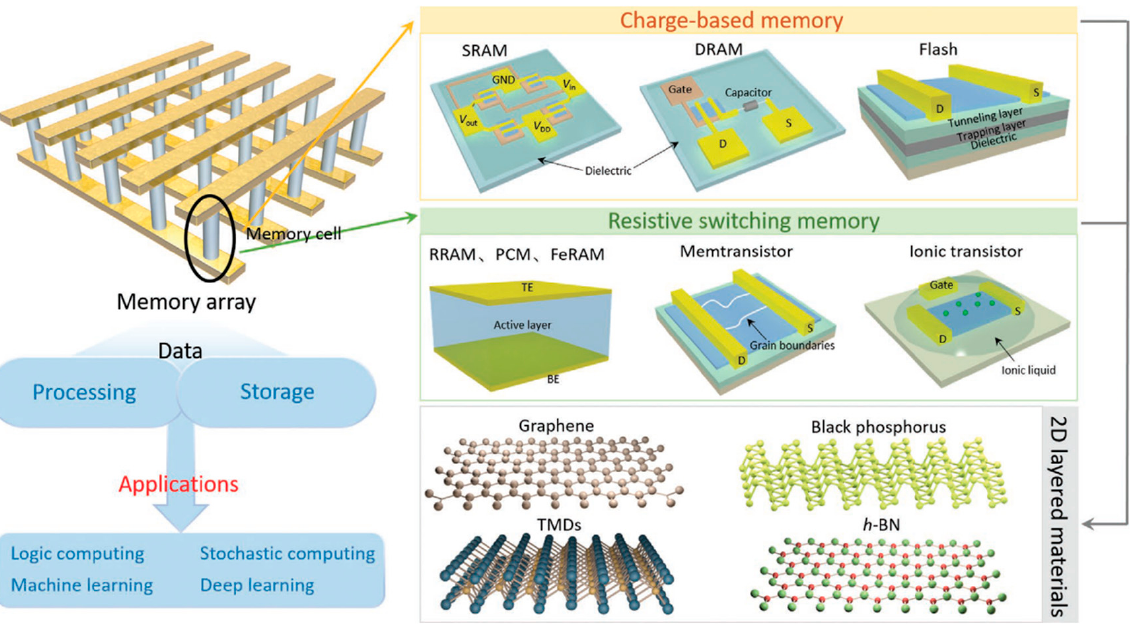
Figure 9. Memory devices based on 2D materials for in-memory computing. In the case of in-memory computing, logic operations are executed in situ within an individual memory unit, which basically includes charge-based memory (i.e., SRAM, DRAM, and Flash) and resistive switching memory (i.e., RRAM, PCM, FeRAM, memtransistor, and ionic transistor). Adapted with permission from [25]. Copyright © 2016